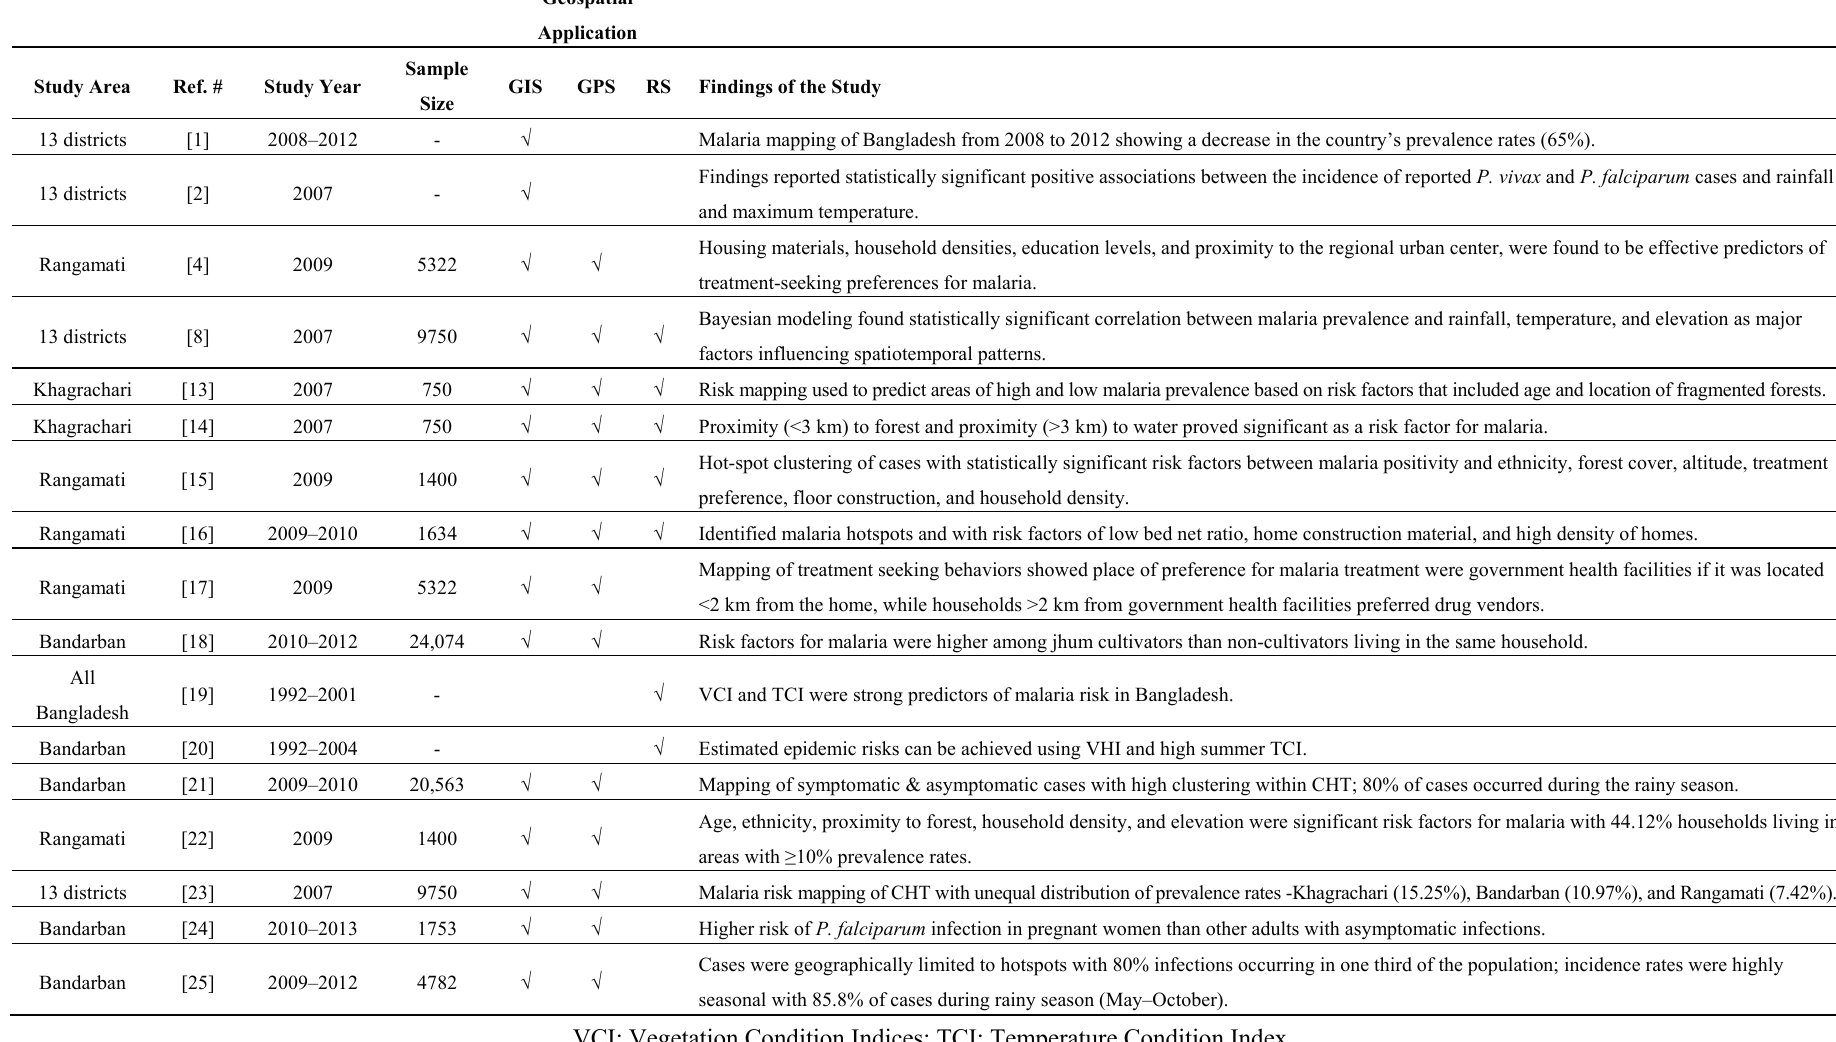
Table 1. Malaria risk mapping studies in Bangladesh,